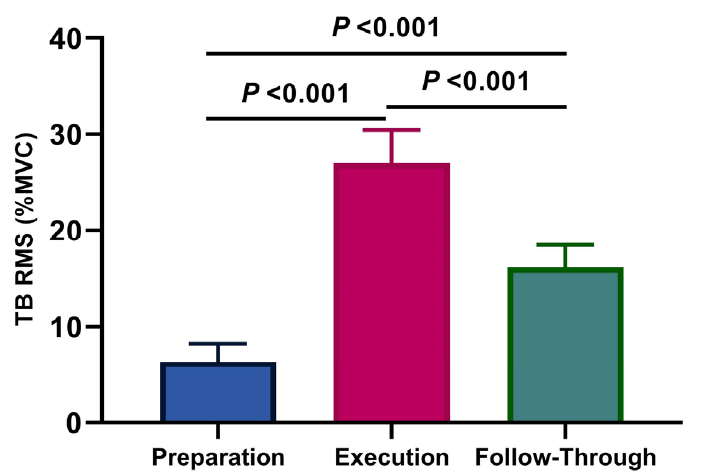
Figure 3. Average values and standard deviations for the normalized EMG (%MVC) per phase of the Triceps brachii ( η 2 p = 0.97).